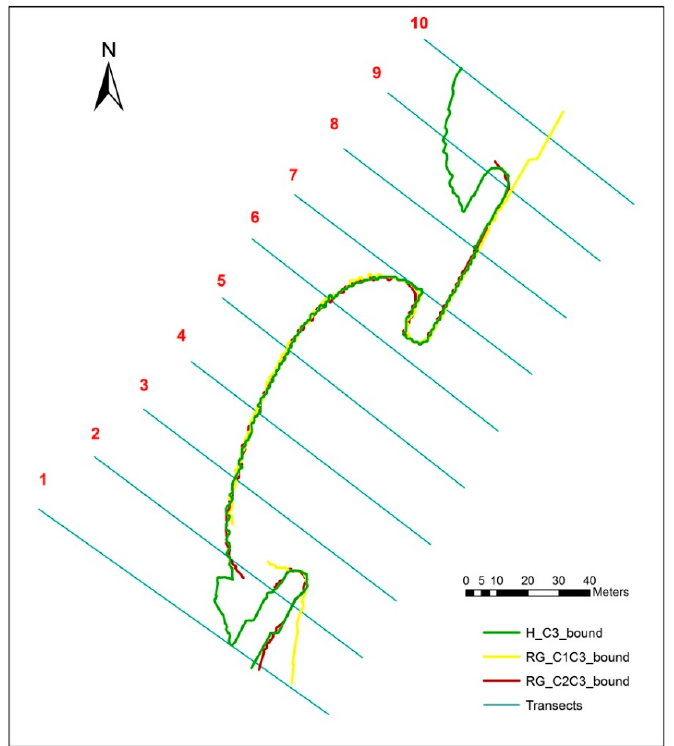
Figure 10. Land/water boundary delineation.